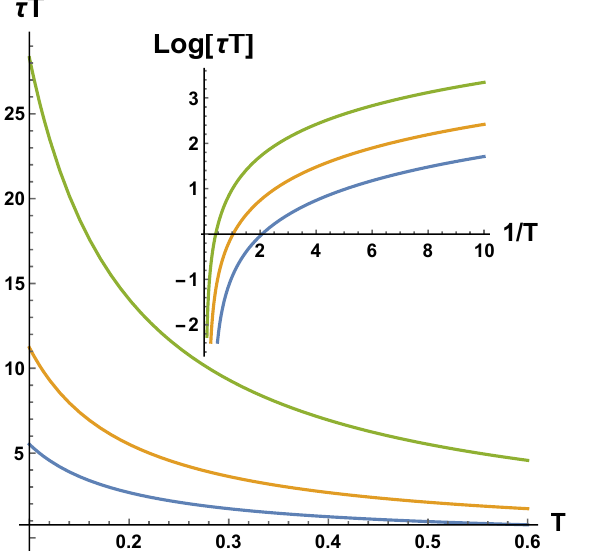
Figure 5 . The relaxation time (cid:28) in function of temperature at (cid:12)xed M =T = 10 ; 20 ; 50 (from blue to